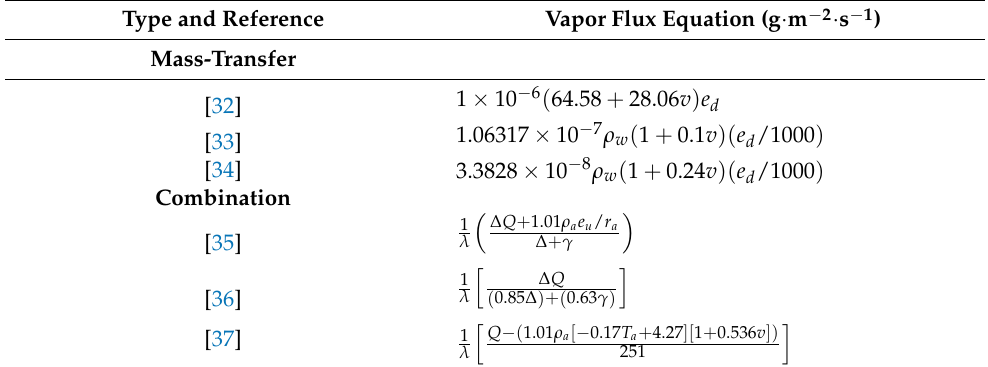
Table 4. Summary of empirical equations for estimation of evaporative flux, modified after Suchan and Azam [24]. Type and Reference